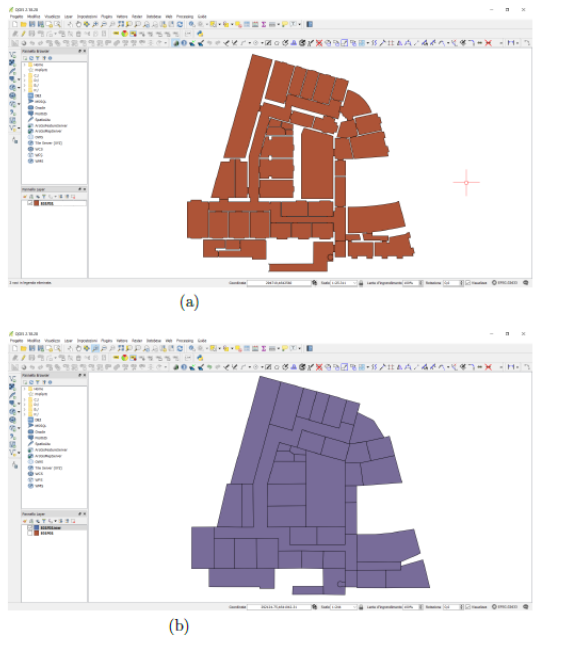
Figure 1. (a) The top panel shows the original layout. (b) the bottom panel depicts the simplified